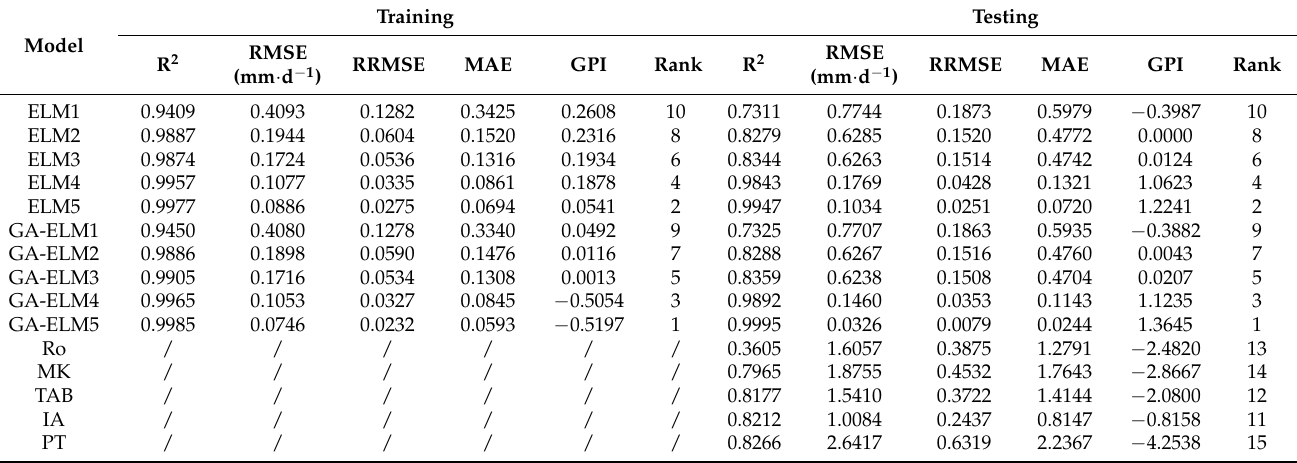
Table 4. Statistical performance of ET 0 models in Southwest